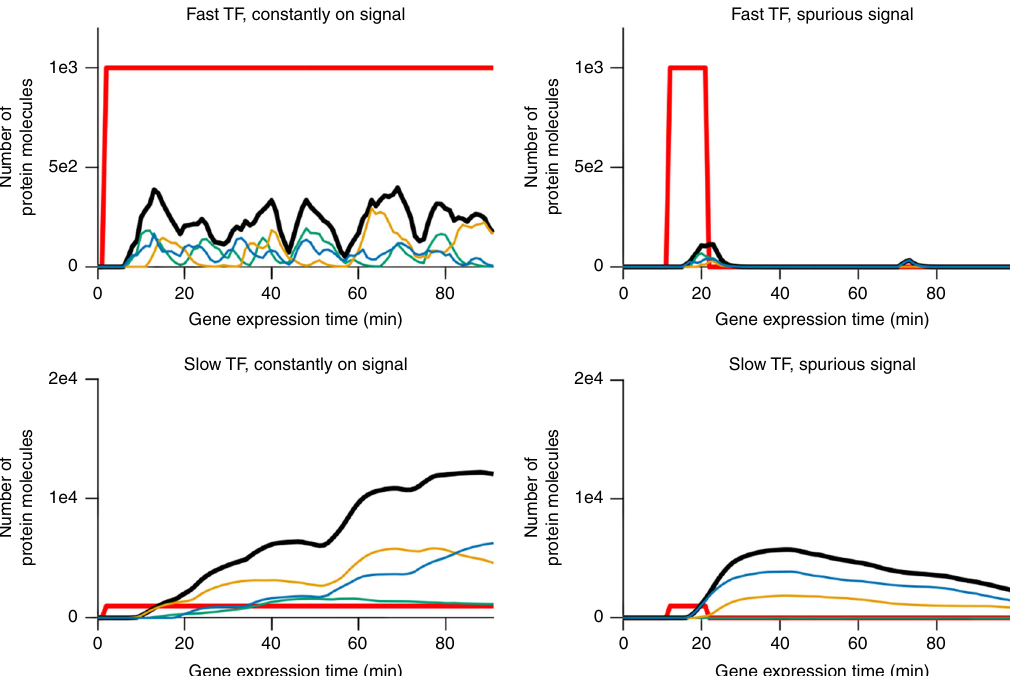
Fig. 8 The two TFs in an AND-gated diamond propagate the signal at different speeds. Expression of the two TFs in one representative genotype from the one high- fi tness evolutionary replicate in Fig. 7b that evolved an AND-gated isolated diamond is shown. Both the slow TF and the fast TF are encoded by three gene copies, shown separately in color, with the total for each TF in thick black. The expression of one TF plateaus faster than that of the other; this is characteristic of the AND-gated diamond motif, and leads to the same functionality as the AND-gated